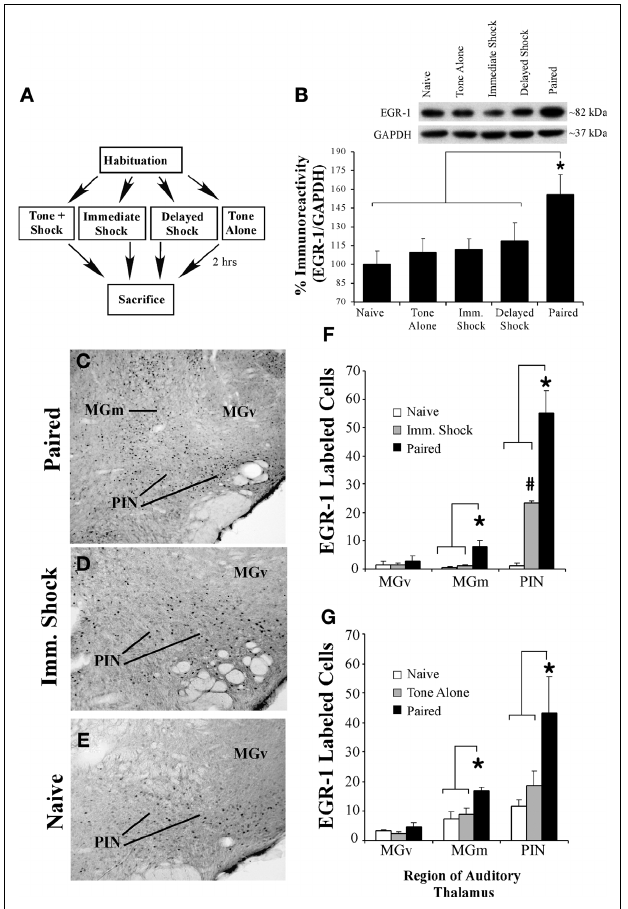
FIGURE 1 | Fear conditioning regulates EGR-1 expression in the MGm/PIN. (A) Schematic of the behavioral protocol. (B) Western blot analysis of EGR-1 protein in the MGm/PIN of Paired ( n = 8), Tone Alone ( n = 8), Imm. Shock ( n = 8), Delayed Shock ( n = 8), and Naïve ( n = 8) groups following fear conditioning. * p < 0.05 relative to Naïve, Tone Alone, Imm. Shock, and Delayed Shock groups. Representative blots can be seen in the inset. (C) Representative 10X photomicrograph of immunolabeled EGR-1 neurons in a Paired rat. (D–E) Representative 20X photomicrographs of immunolabeled EGR-1 neurons in an Imm. Shock and Naïve rat, respectively. (F) Quantifi cation of EGR-1 labeled cells in the MGv, MGm, and the PIN of Paired ( n = 3), Imm. Shock ( n = 3), and Naïve ( n = 3) groups. * p < 0.05 relative to Naive and Imm. Shock groups. # p < 0.05 relative to Naïve group. (G) Quantifi cation of EGR-1 labeled cells in the MGv, MGm, and the PIN of Paired ( n = 4), Tone Alone ( n = 4), and Naïve ( n = 4) groups. * p < 0.05 relative to Naive and Tone Alone